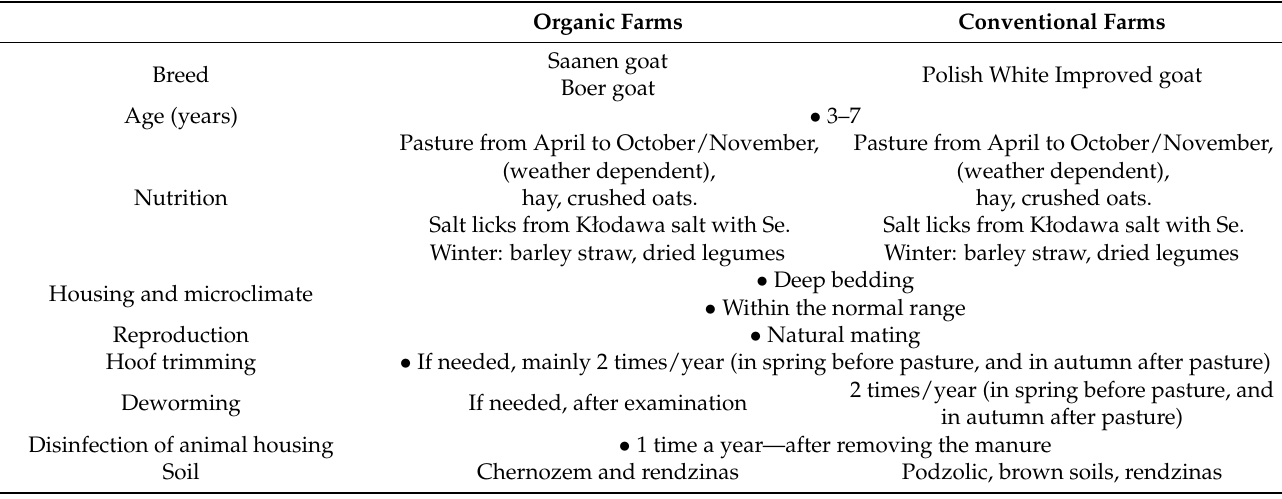
Table 1. Characteristic of organic and conventional farms. Organic